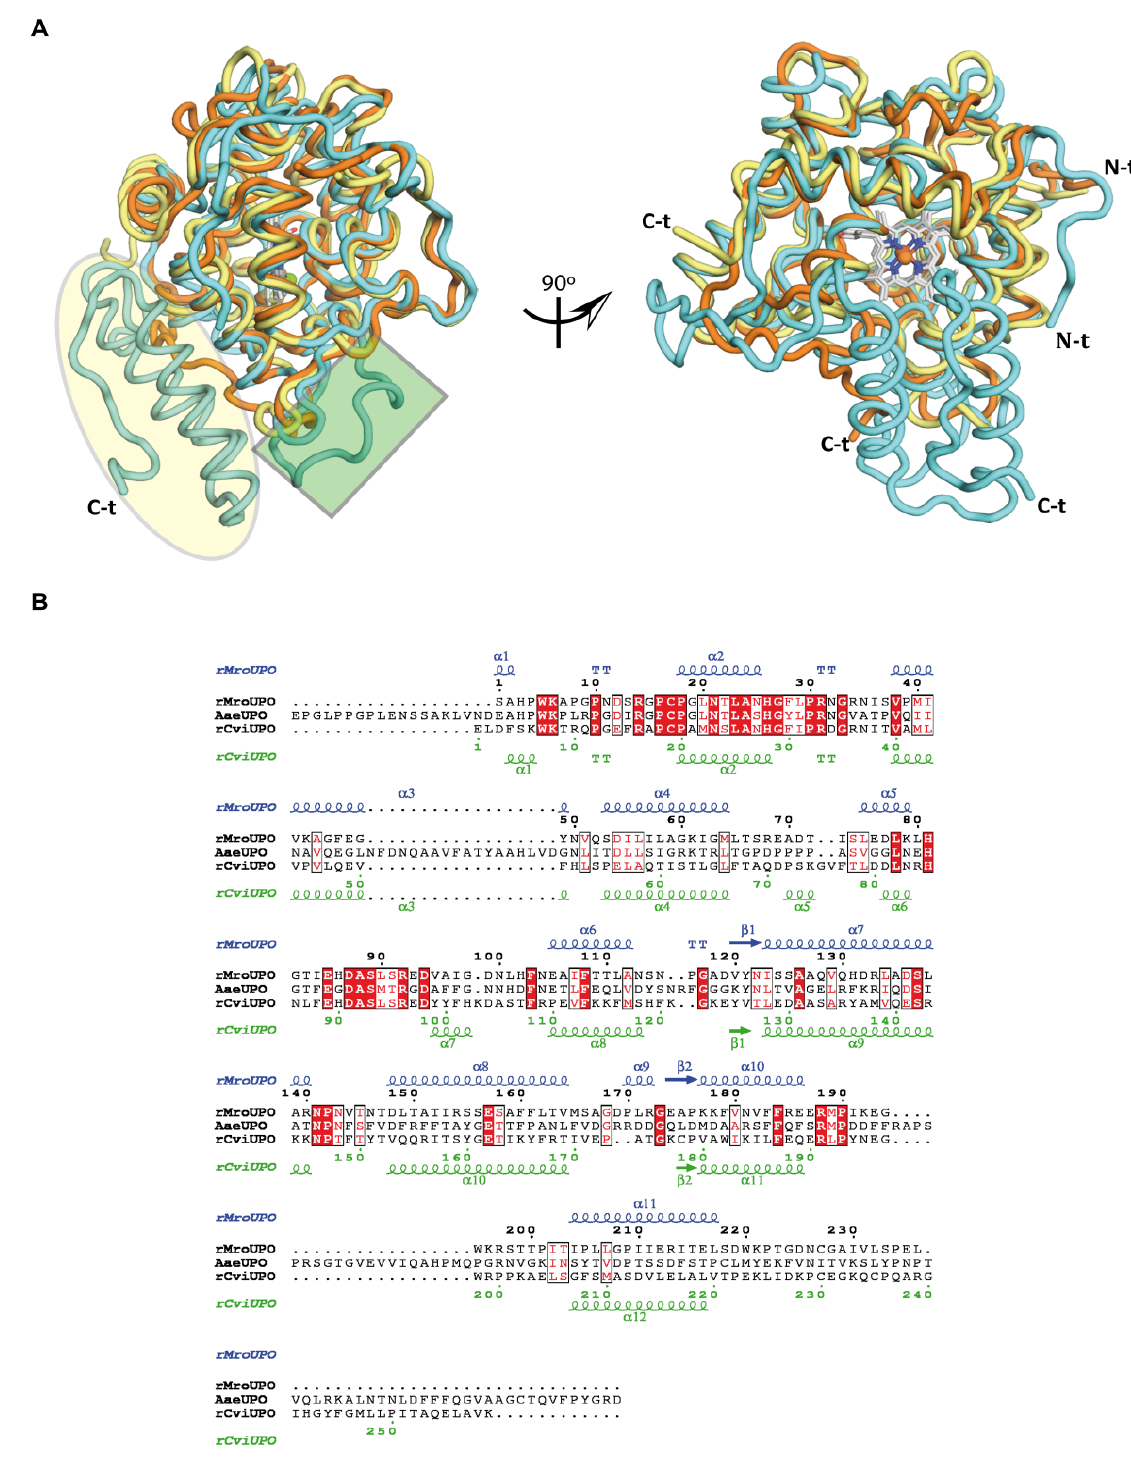
Figure 6. Structural and sequence comparisons. ( A ) Structural alignment of r Mro UPO (7ZBP, orange), r Cvi UPO (7ZCL, yellow), and Aae UPO (2YOR, cyan). The main differences are at the long loop in Aae UPO in relation to the loop including the α 3 helix in the short UPOs (green square), and the longer C-terminal tail in Aae UPO (highlighted in yellow). ( B ) Sequence alignment of the two short UPOs with Aae UPO. Strictly conserved residues are shown in red boxes, and red characters in white boxes specify similarity. The top and bottom lanes show the secondary structure of r Mro UPO and r Cvi UPO, respectively, with α , β , and TT representing α helices, β sheets, and turns, respectively.